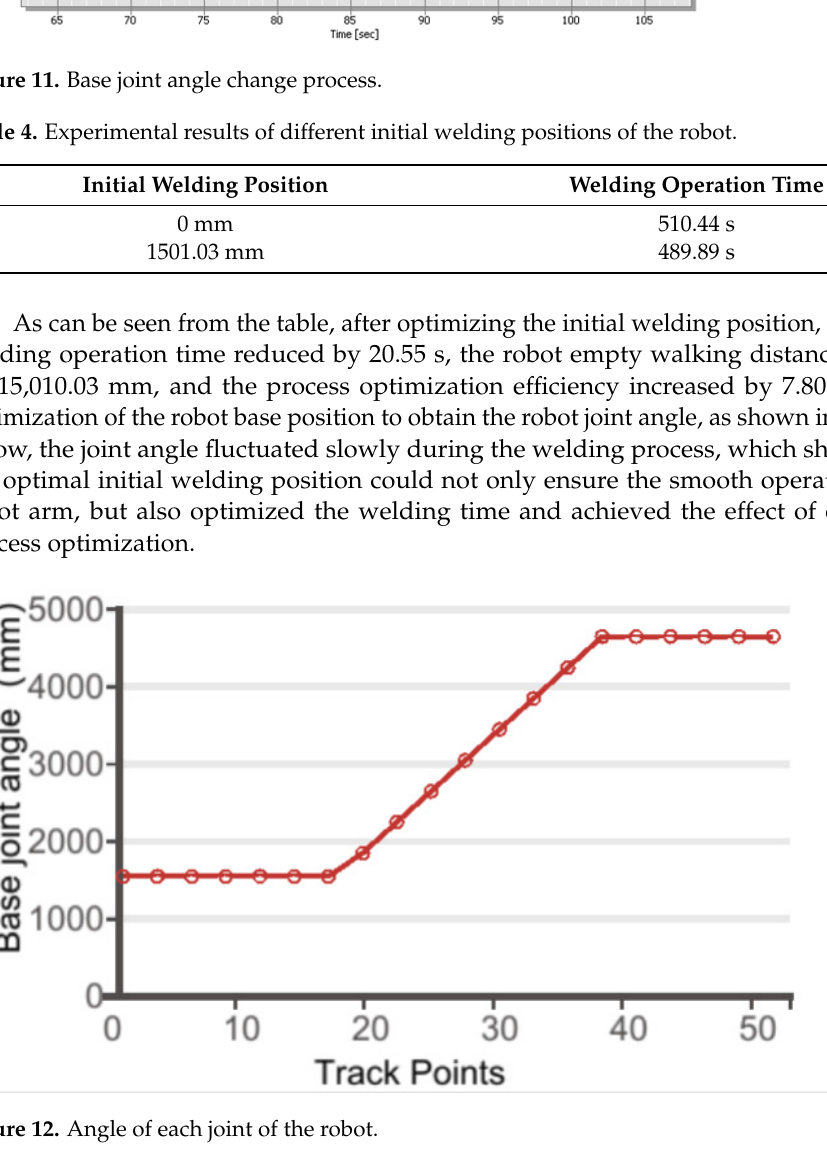
Table 4. Experimental results of different initial welding positions of the